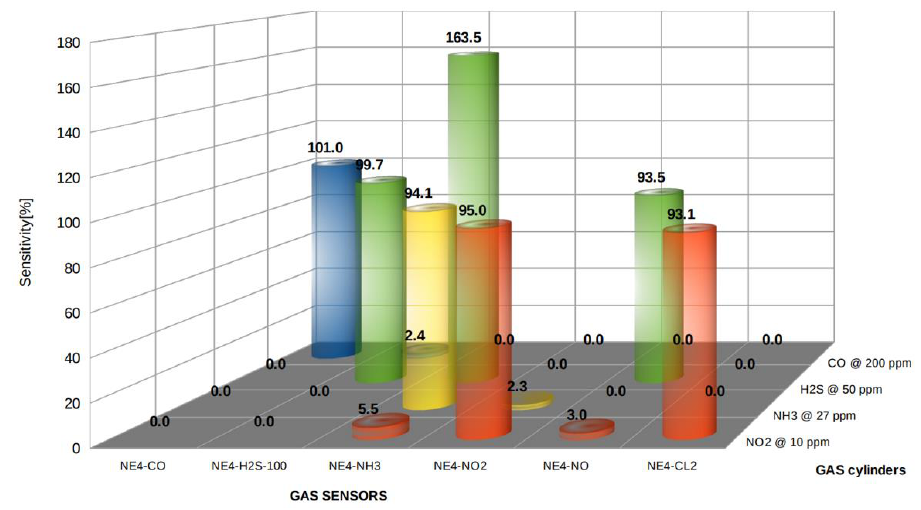
Figure 3. Gas calibration curves. ( a ) CO gas standard vs. CO sensor; ( b ) NH 3 gas standard vs. NH 3 sensor; ( c ) NO 2 gas standard vs. NO 2 sensor.